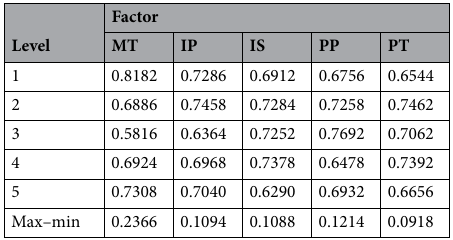
Table 17. Main influences of factors for